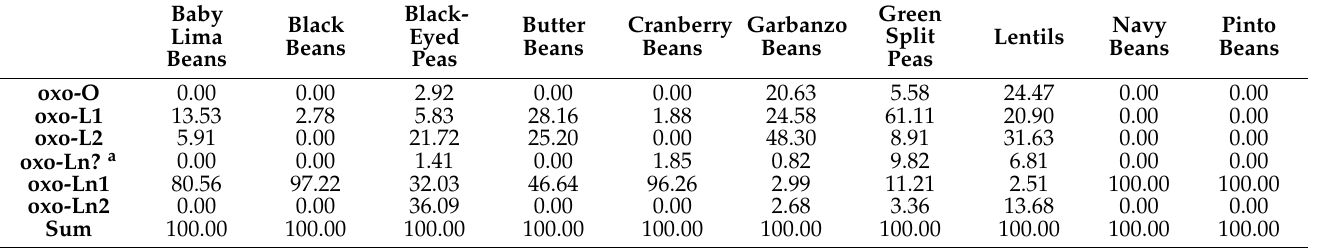
Table 4. Distributions of oxygenated 18-carbon fatty acid isomers expressed as percentages of total oxygenated fatty acid content as determined from GC-FID peak